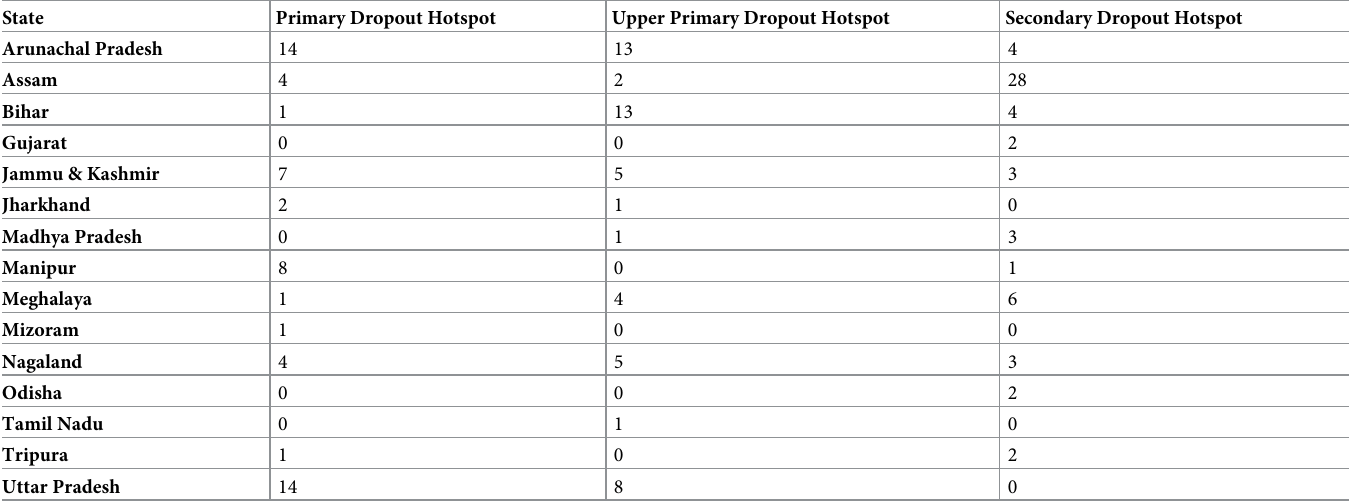
Table 2. District-level hotspots of school dropouts.